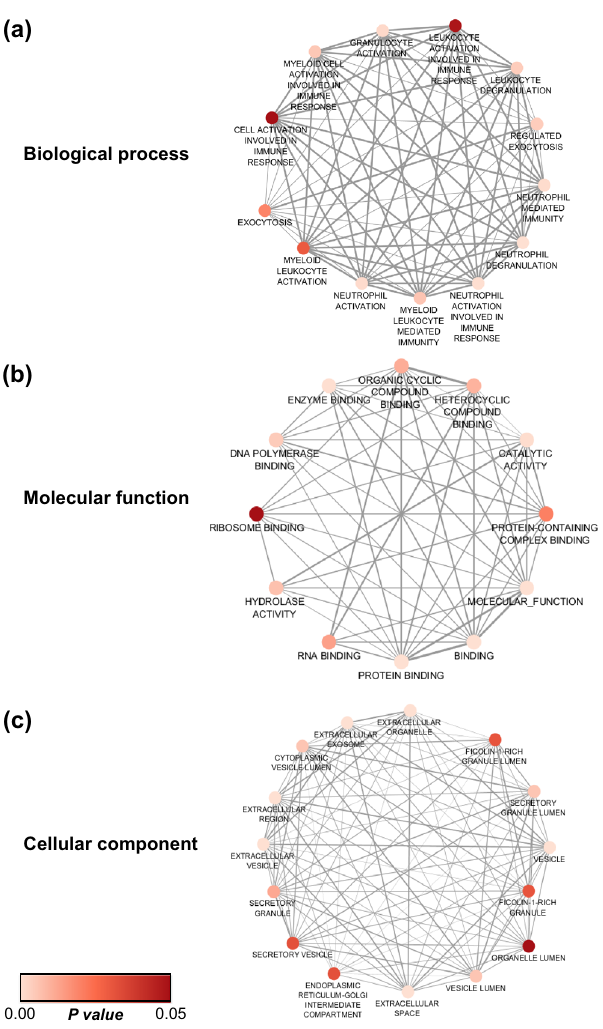
Fig. 3 Functional annotation of the signi fi cantly altered secreted proteins. Functional enrichment analyses of all signi fi cantly altered secreted proteins identi fi ed from label-free quantitative proteomics using nanoLC-ESI-LTQ- Orbitrap MS/MS (as detailed in Fig. 2 and Table 1) were performed in g: Pro fi ler web server using g:GOSt tool (https://biit.cs.ut.ee/gpro fi ler/gost). Their biological processes ( a ), molecular functions ( b ), and cellular components ( c ) were visualized using Cytoscape (version 3.7.2). Data 6) and MMP-2 (Fig. 9c and Supplementary Data 7) levels were signi fi cantly greater in the COM-MP secretome-treated BHK-21 cells compared with the untreated and Ctrl-MP secre- tome-treated fi broblasts. Taken together, all these data indicate that the COM-MP secretome triggered transformation of renal fi broblast into its active form, myo fi broblast. Discussion